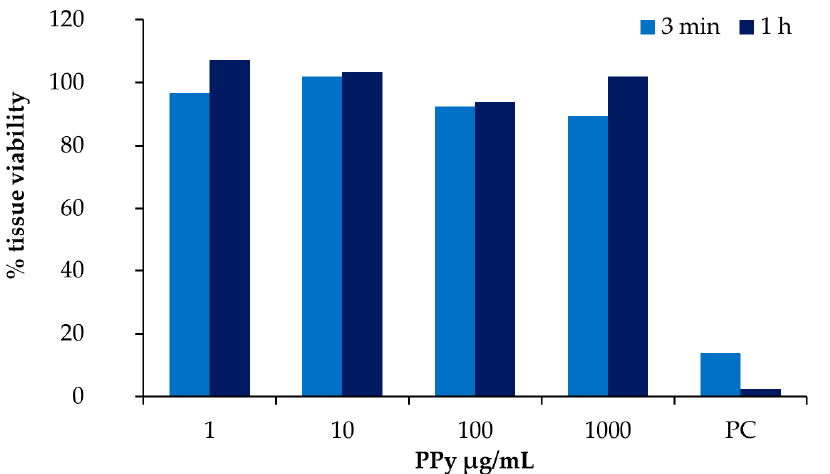
Figure 7. Corrosion skin test. EpiDerm™ was exposed for 3 min and 1 h to PPy NPs (1, 10, 100, and 1000 µg/mL) and the % of tissue viability was assessed through MTT test. Potassium hydroxide (KOH) at the concentration of 8 M was used as a positive control (PC), and PBS 1X as a negative control. The bars represent the mean values of two repetitions (N = 2) for each test conditions.